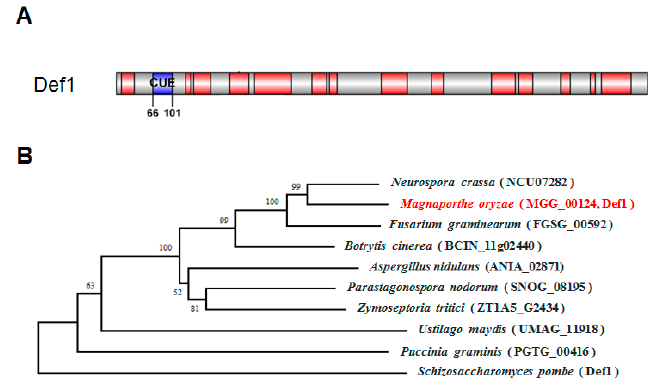
Figure 1. Characterization of Def1 protein in M. oryzae . ( A ) Conserved domain of Def1 protein M. oryzae predicted by SMART. ( B ) Phylogenetic tree of the Def1 proteins in different organisms using the neighbor-joining method by MEGA software (version 5.2.2).